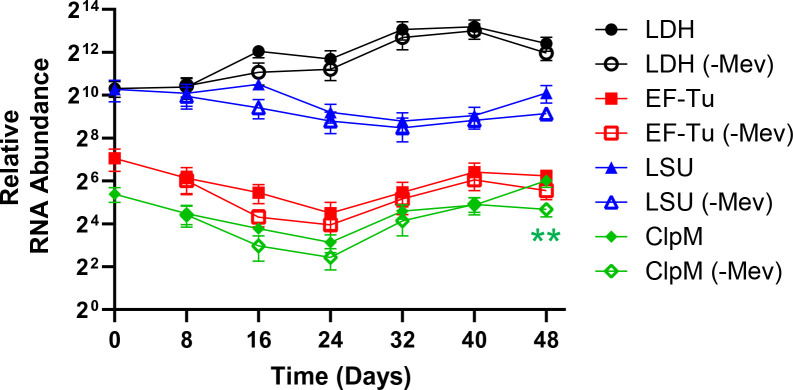
Mevalonate dependence of apicoplast and nuclear transcripts in PfMev Δdxs parasites quantified using RT-qPCR.The relative transcript abundance of nuclear-encoded LDH and apicoplast encoded EF-Tu, LSU, and ClpM is shown in PfMev Δdxs parasites cultured with mevalonate (filled symbols) or without mevalonate (open symbols). Samples from biological duplicates were collected at 8 hr intervals for 48 hr followed by RNA extraction and cDNA synthesis. RT-qPCR was performed with technical triplicates and quantified relative to samples of pure parasite DNA. Mevalonate deprivation and loss of isoprenoid synthesis does not cause a significant reduction in transcript abundance until the 48 hr time point, indicating that reduced apicoplast transcription (as observed in the CLD-PyrKII line) is not an early consequence of general metabolic dysfunction (two-way ANOVA, followed by Bonferroni’s correction; **, p<0.01). Error bars represent the standard error of the mean (SEM).